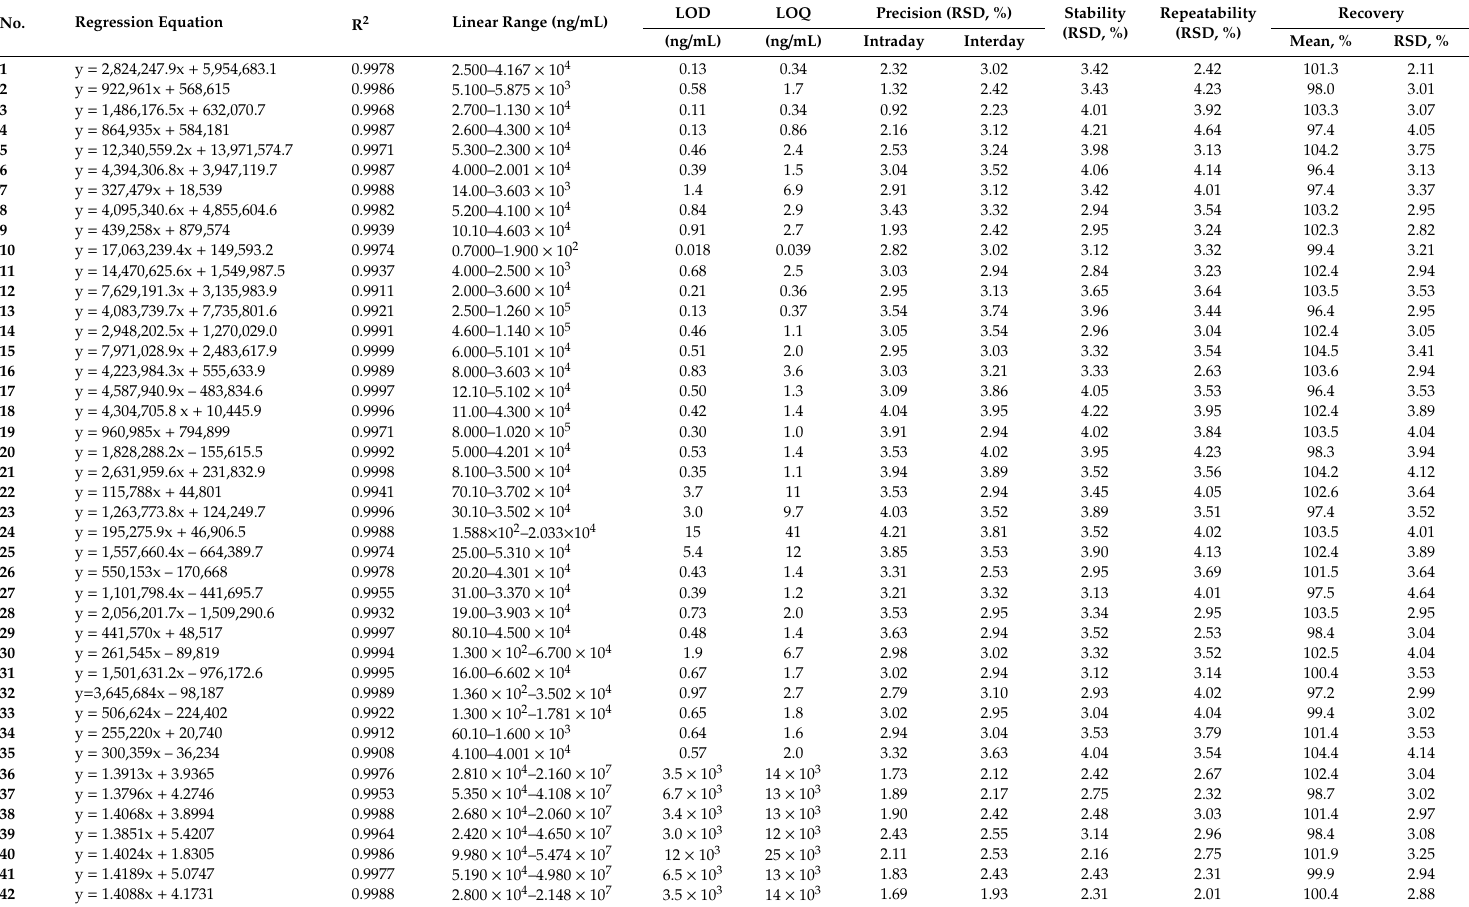
Table 2. Linear regression, LOD, LOQ and precision, stability, repeatability, recovery of the